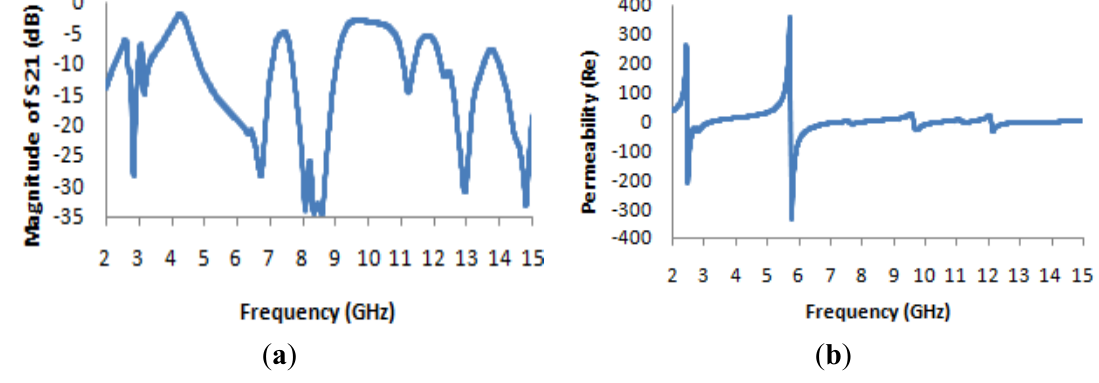
Figure 13. ( a ) The magnitude of the transmission parameter (S 2 × 2 array of the unit structure; ( b ) the real value of permeability vs. the frequency for the 2 × 2 array of the unit structure.